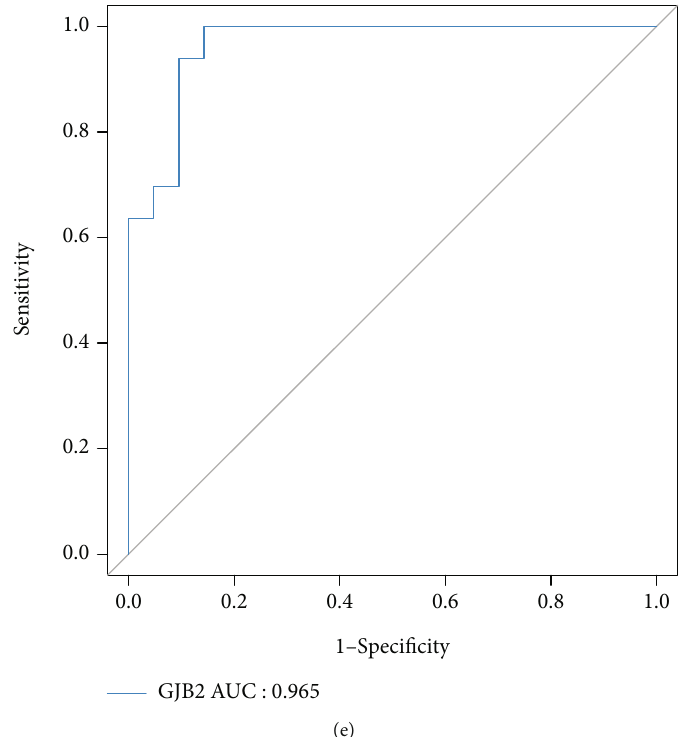
Figure 6: Evaluation of diagnostic value of GJB2 by Wilcoxon rank-sum test and ROC curves. (a) The expression of GJB2 between healthy controls and psoriasis lesions in GSE13355. (b) The expression of GJB2 between healthy controls and psoriasis lesions in GSE14905. (c) The DNA methylation levels of GJB2 between healthy controls and psoriasis lesions in GSE73894. (d) Evaluation of GJB2 AUC in GSE13355. (e) Evaluation of GJB2 AUC in